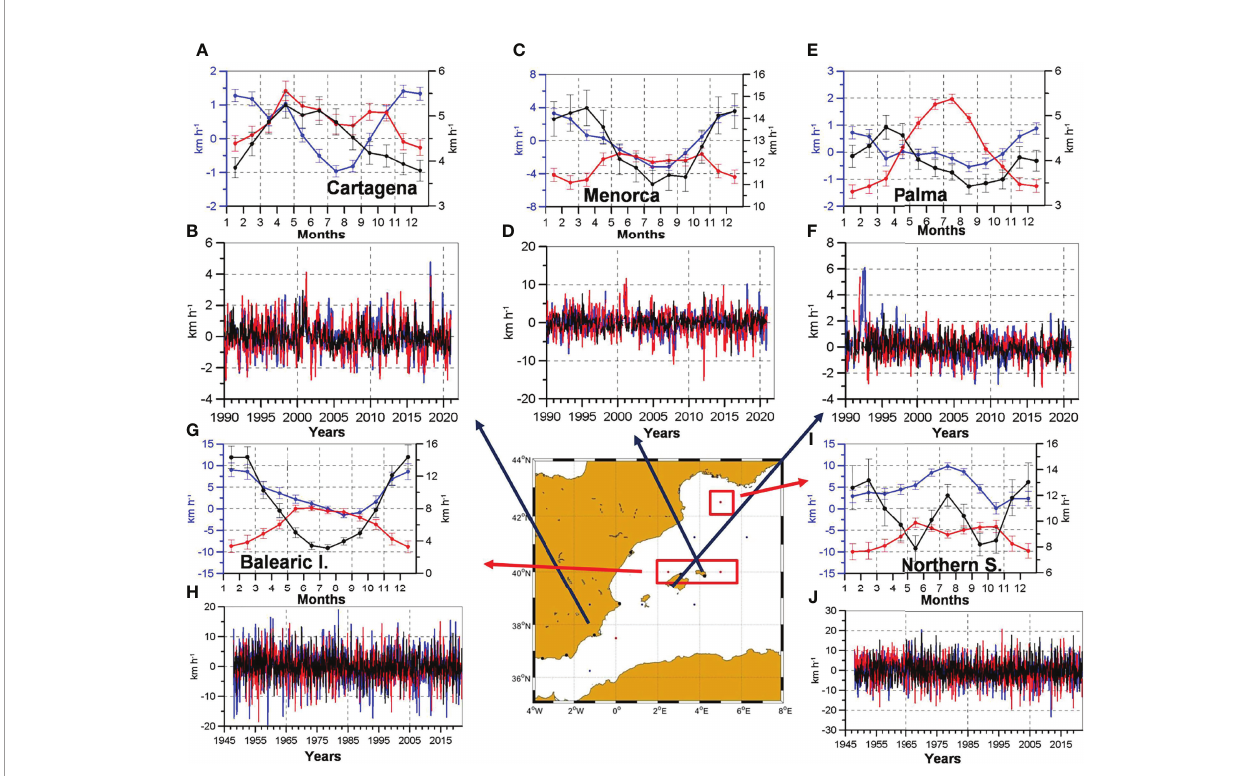
FIGURE 8 | (A, C, E) are the seasonal cycles of west-east component of the wind (blue lines and left axis), south-north component (red lines and left axis) and the wind intensity (black lines and right axis) for the meteorological stations of Cartagena, Menorca, and Palma. (B, D, F) are the corresponding time series of anomalies. (G, I) are the wind seasonal cycles for the regions of Balearic Islands and the Northern Sector, using the reanalysis data. (H, J) are the corresponding time series of